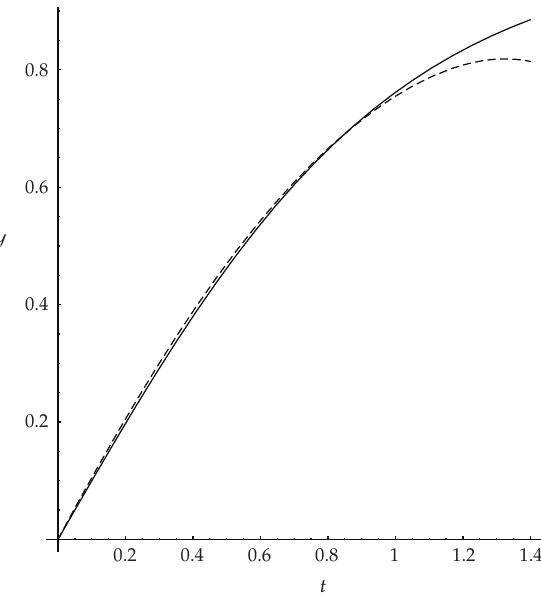
Figure 2: Dashed line: Approximate